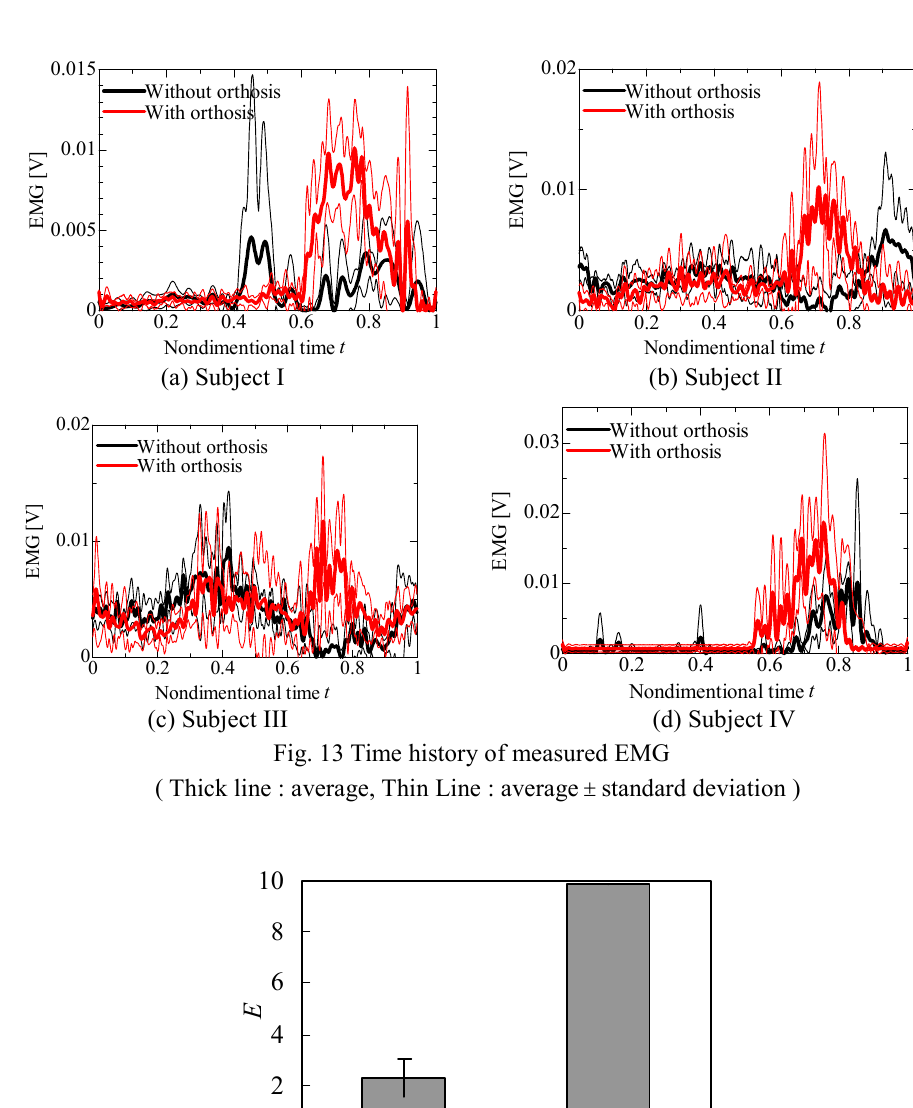
Fig. 14 Averaged value of